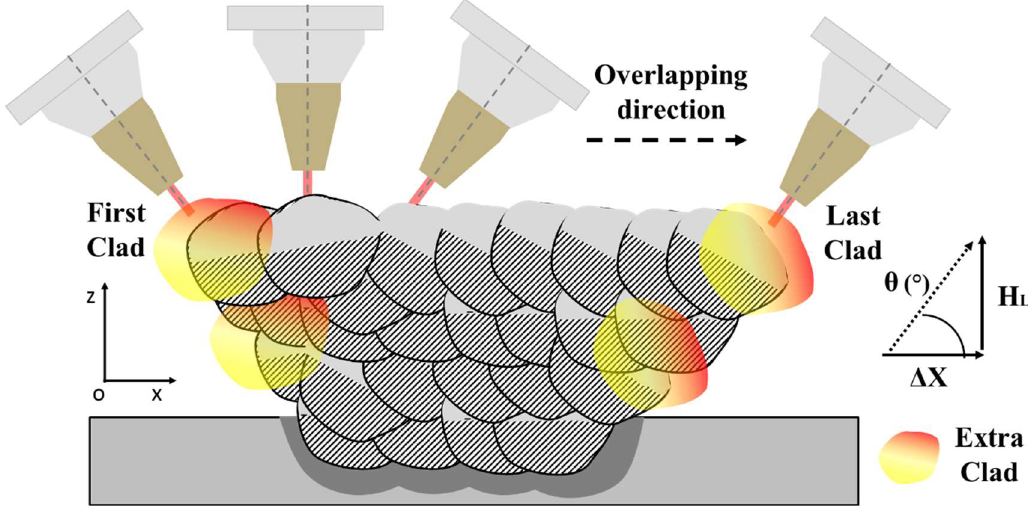
Figure 3. Scheme of the deposition strategy. Dove tail cross section.